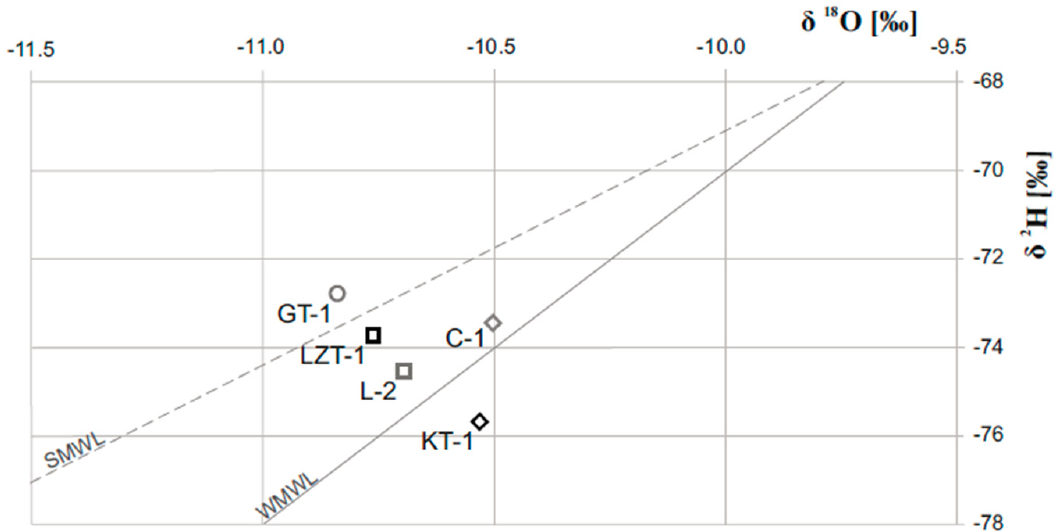
Figure 3. Isotopic composition of thermal waters from particular locations (based on [42, 44,49,56].